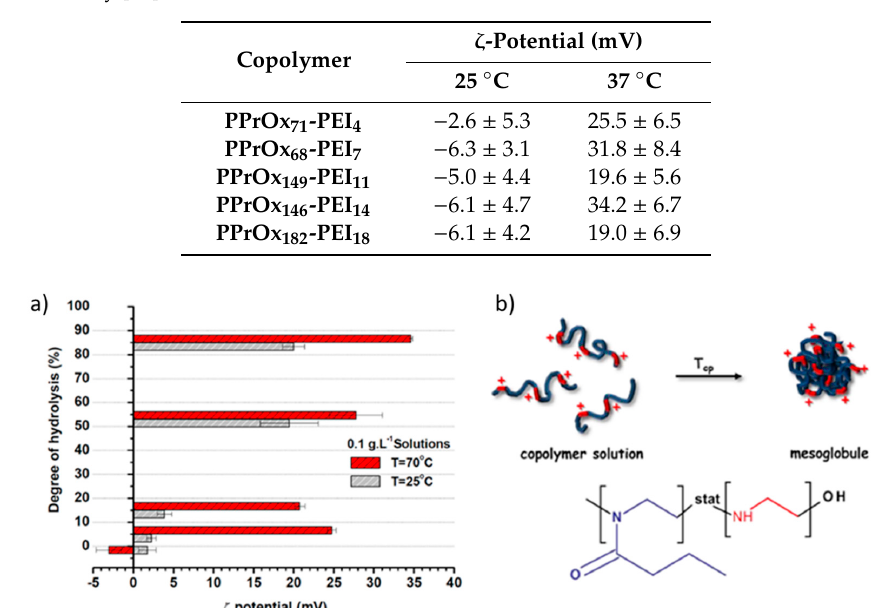
Figure 4. Variations of ζ potential of PiPOx–PEI copolymers with DH and temperature ( a ). Adapted from Toncheva-Moncheva et al. as published by the Elsevier [42]. Schematic representation of the formation of positively charged mesoglobules from PnPOx–PEI copolymers ( b ). Adapted from Mees et al. as published by the American Chemical Society [41]. copolymers (Figure 5a). The copolymers were amphiphilic but, noteworthily, not thermosensitive, and formed aggregates composed of a PPhOx core surrounded by randomly situated PMeOx segments and PEI loops. The aggregates exhibited entirely positive ζ potential (24–35 mV) and size ranging from 95 to 164 nm. The proposed structure of the aggregates (Figure 5b) is quite similar to those formed by the thermoresponsive POx–PEI copolymers at elevated temperatures.